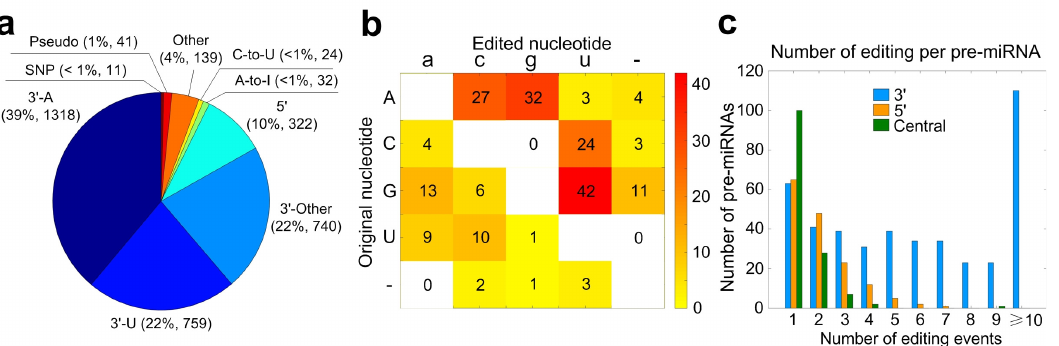
Figure 3. A summary of the identified miRNA mutation and editing sites of Macaca mulatta . ( a ) The categories of significant M/E sites in miRNAs. ( b ) The numbers of different types of editing events that do not happen at the 5’ or 3’ end of mature miRNAs. ( c ) The distribution of the numbers of pre-miRNAs with different numbers of 5’- and 3’-editing, and Central editing sites, i.e., editing sites that do not happen at either ends of mature